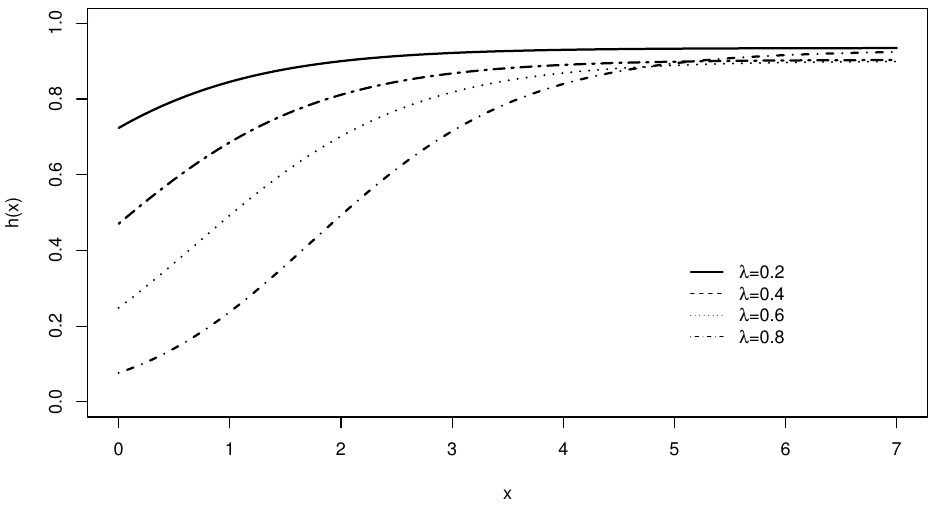
Figure 3. The plots of the HRF of the LiE1 distribution for various choices of parameter λ with θ =